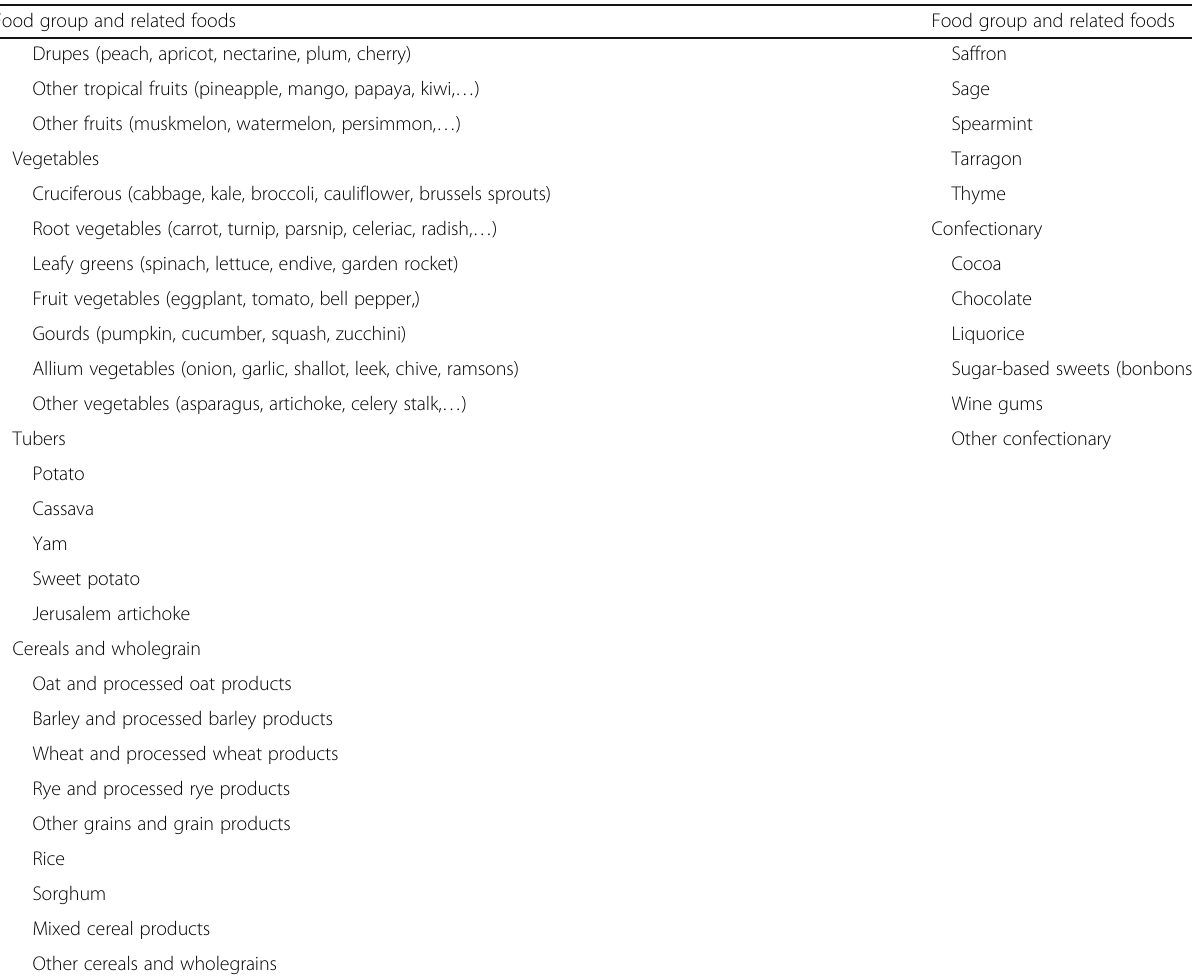
Table 1 Principal food groups that need investigation by the BFIRev procedure (Continued) Food group and related foods Food group and related